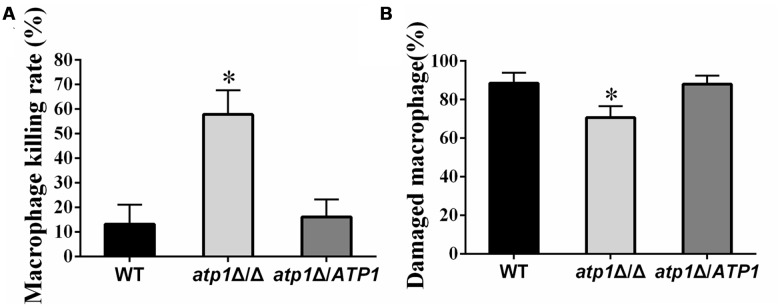
Interaction between C. albicans and macrophages. (A) Viability of all strains is shown after an overnight incubation with macrophages (RAW264.7). Viable colonies of each strain were counted under microscopy. Data are averages of three separate experiments. ∗P < 0.05 compared with WT. (B) Macrophages were incubated with the indicated strains of C. albicans for 1 h and the extent of macrophages damage was then determined. Data are averages of three separate experiments. ∗P < 0.05 compared with WT.